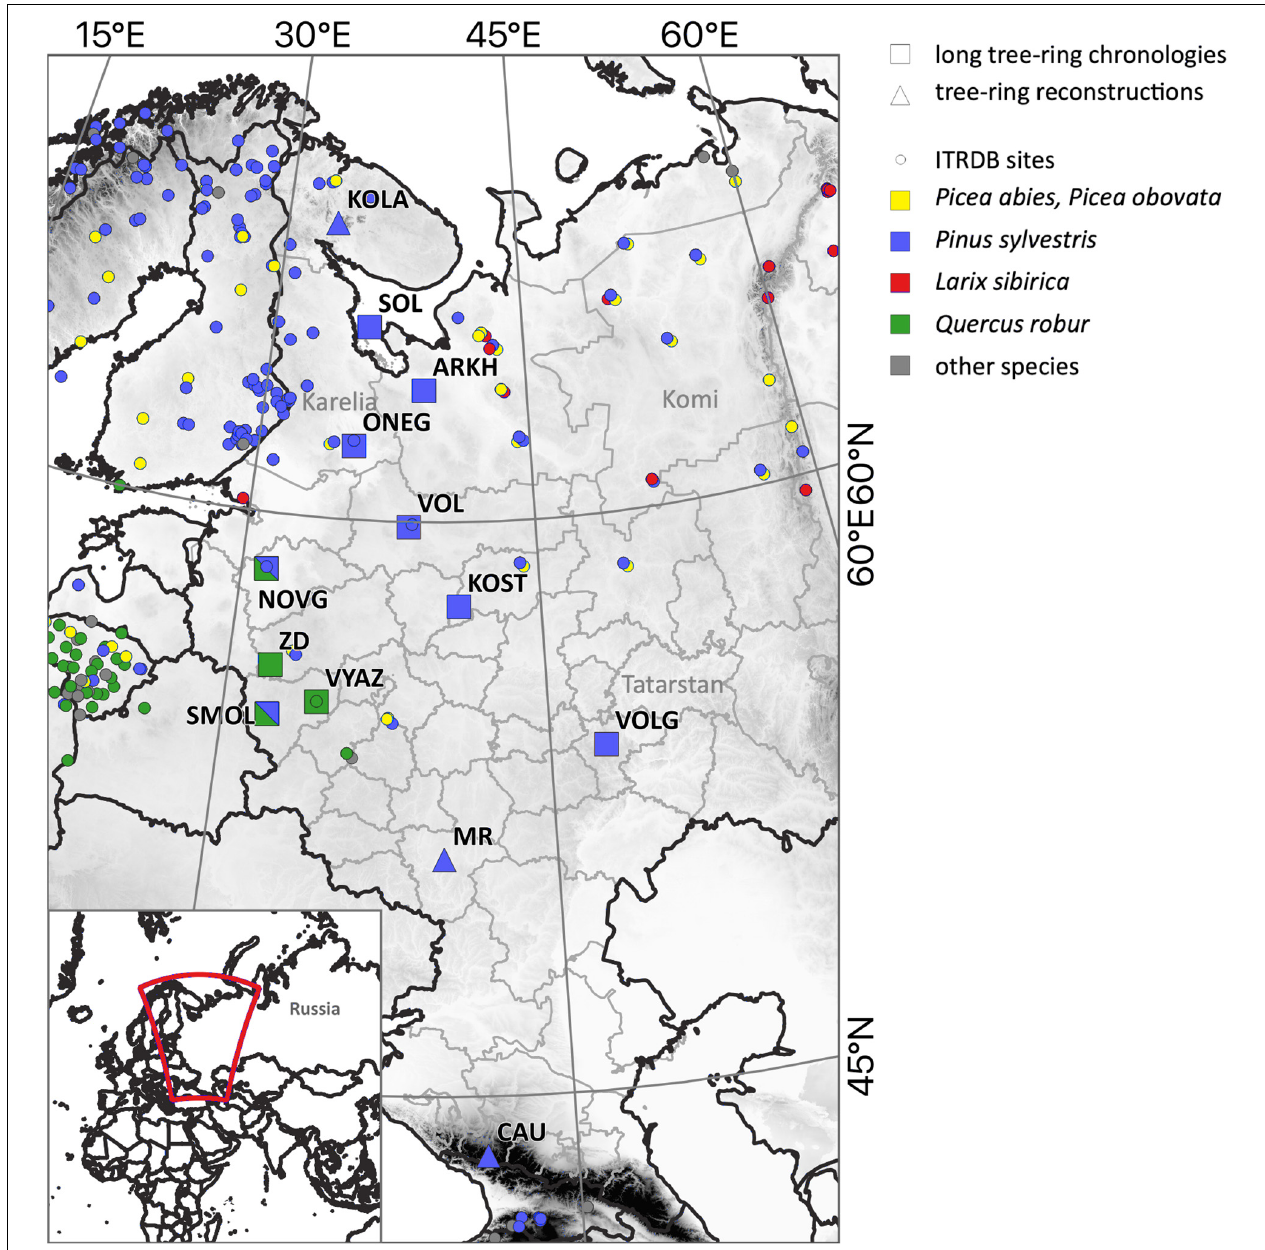
FIGURE 1 | Location of the tree-ring sites in European Russia. KOLA—summer temperature reconstruction (1600–2004, Kononov et al., 2009), MR–SPEI reconstruction (1790–2014, Matskovsky et al., 2016b), CAU—summer temperature reconstruction (1596–2011, Dolgova, 2016). Long tree-ring chronologies are described in Figure 2 . Grayscale shading shows